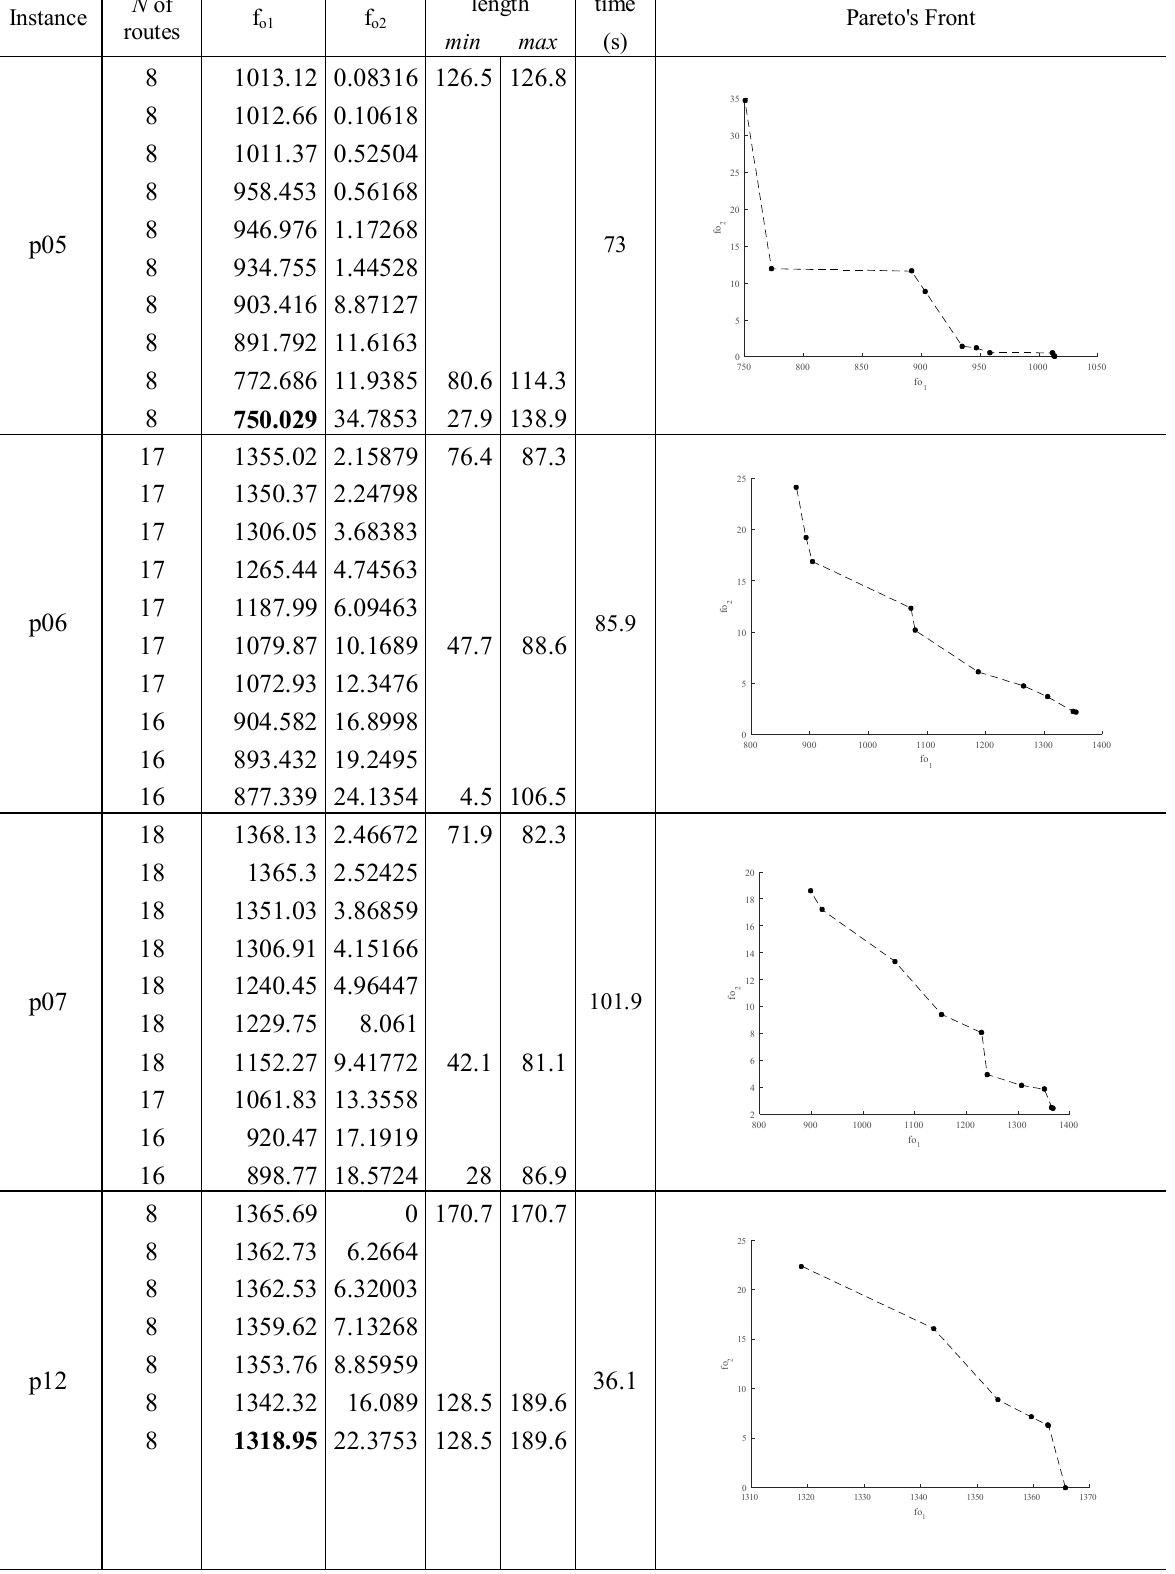
(Continued): Computational results for instances used by Cordeau, et al.